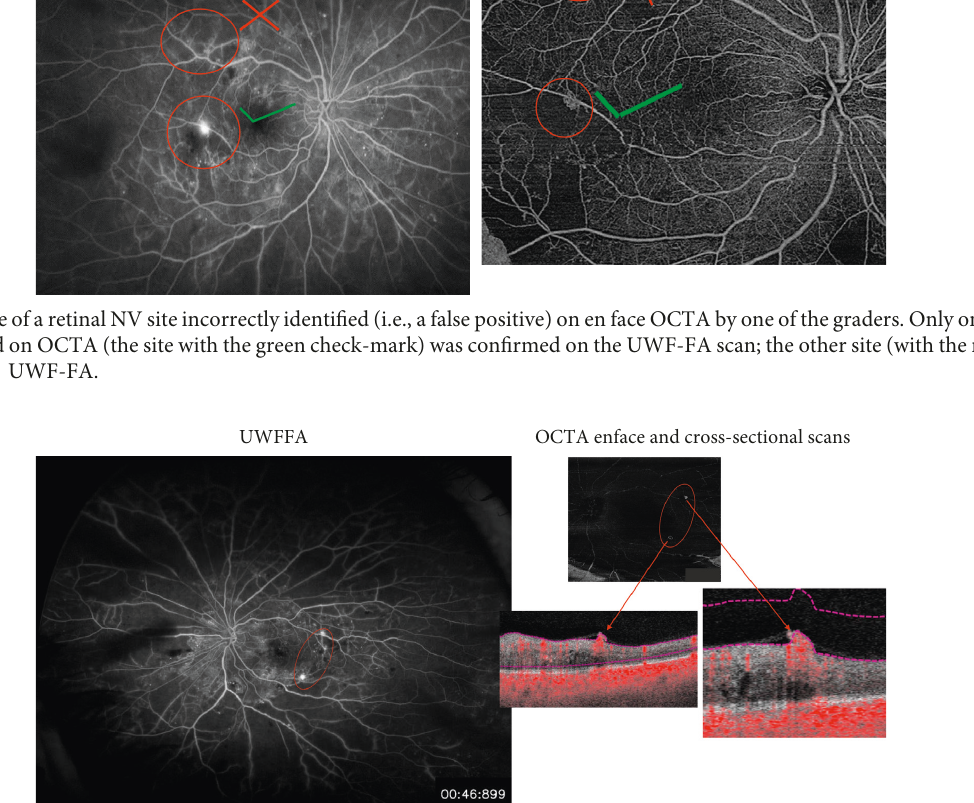
Figure 3: Example of two retinal NV sites seen on UWF-FA (left) and identified on both the en face OCTA scan (top right image) and the corresponding cross-sectional OCTA scans (bottom right images) as extending above the vitreo-retinal